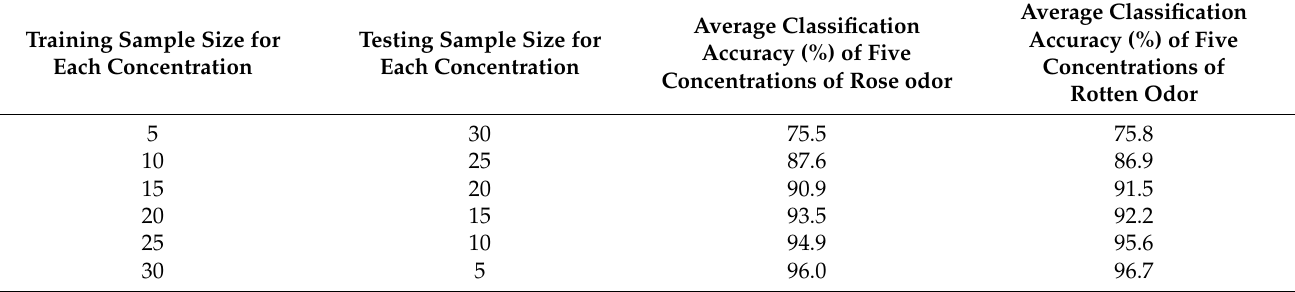
Table 4. Results of accuracy change with sample size in training and testing processes. Take the average classification accuracy of 13 participants as an example. The results are obtained using the SVM to classify PSD features extracted from the gamma band. The percentages represent the average classification accuracies across the